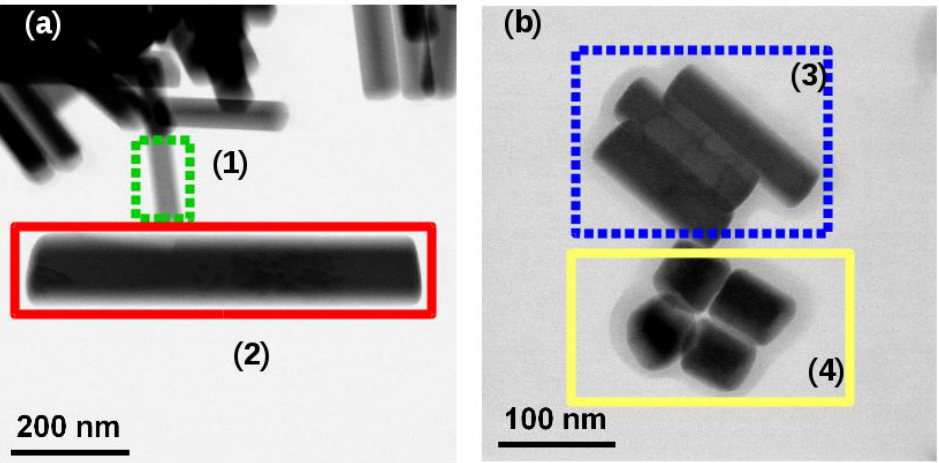
Figure 3. Two TEM images of NaYF 4 NPs from the two batches presenting two NPs populations (( a ) NR11 and ( b )